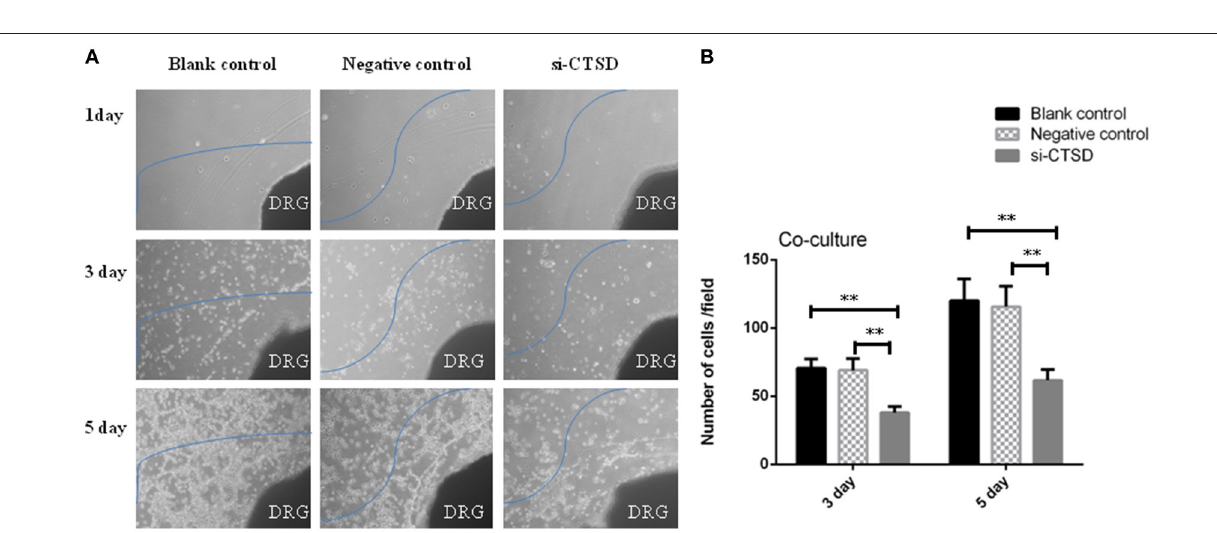
FIGURE 5 | Effect of CTSD on PNI of SACC-LM cells. (A,B) In vitro DRG co-culture assay of PNI showed that CTSD knockdown inhibited the ability of PNI of SACC-LM cells, (40 × ) (** p < 0.01). DRG represents newborn rat dorsal root ganglia